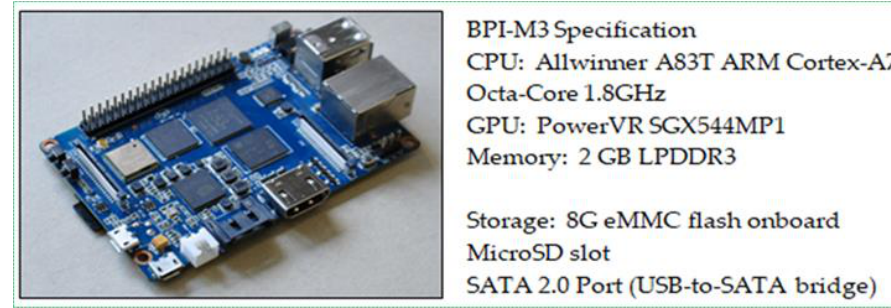
Figure 12. Characteristics of Banana Pi M3.